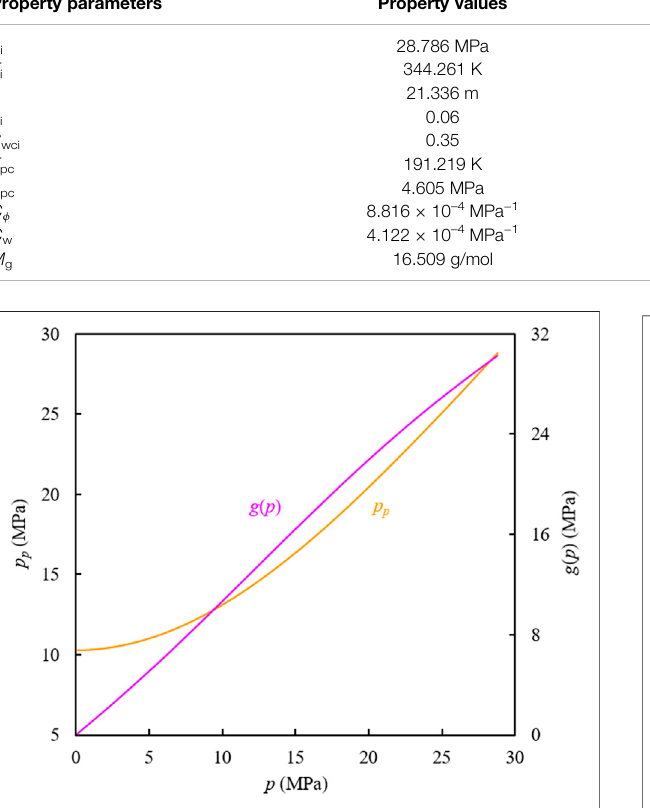
FIGURE 9 | p p and g ( p ) vs. p for the fi eld case.